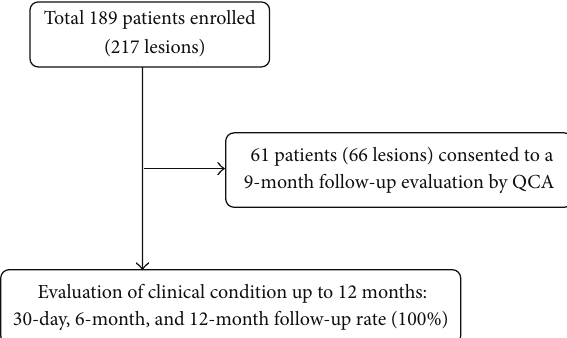
Figure 1: Flow chart of the study.